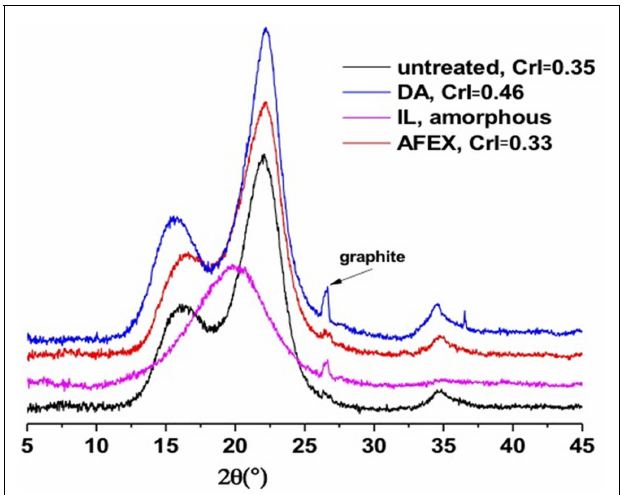
FIGURE 1 | Powder XRD patterns of corn stover samples before and after pretreatment .The CrI refers to biomass crystallinity